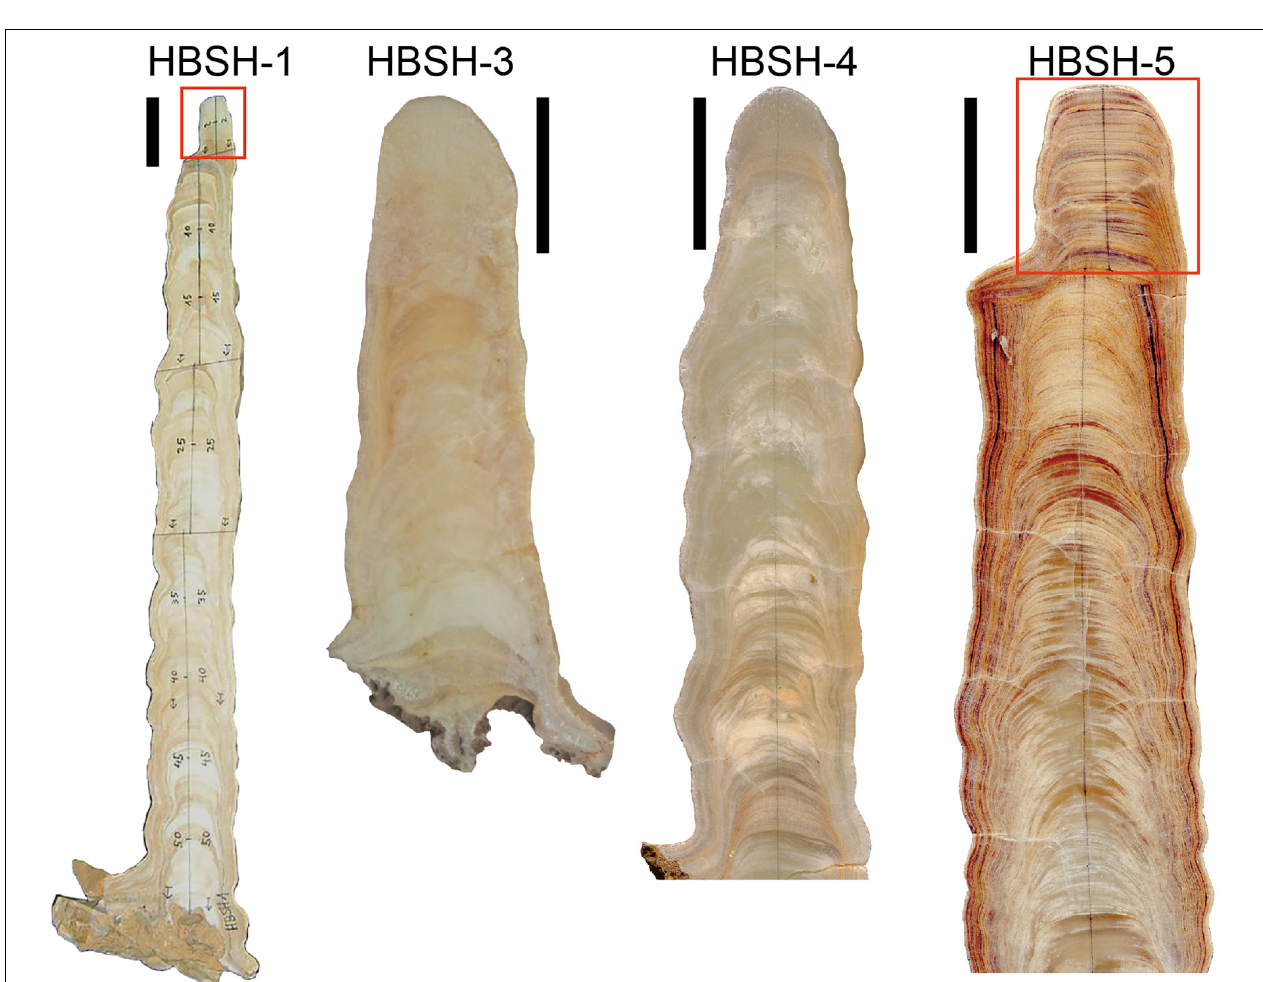
FIGURE 2 | Pictures of the HBSH stalagmites. For HBSH-1 and HBSH-5, only the upper parts covering the Holocene (highlighted by the red box) were investigated. For HBSH-3 and HBSH-4, the major parts grew during the Holocene. All scale bars are 5 cm.